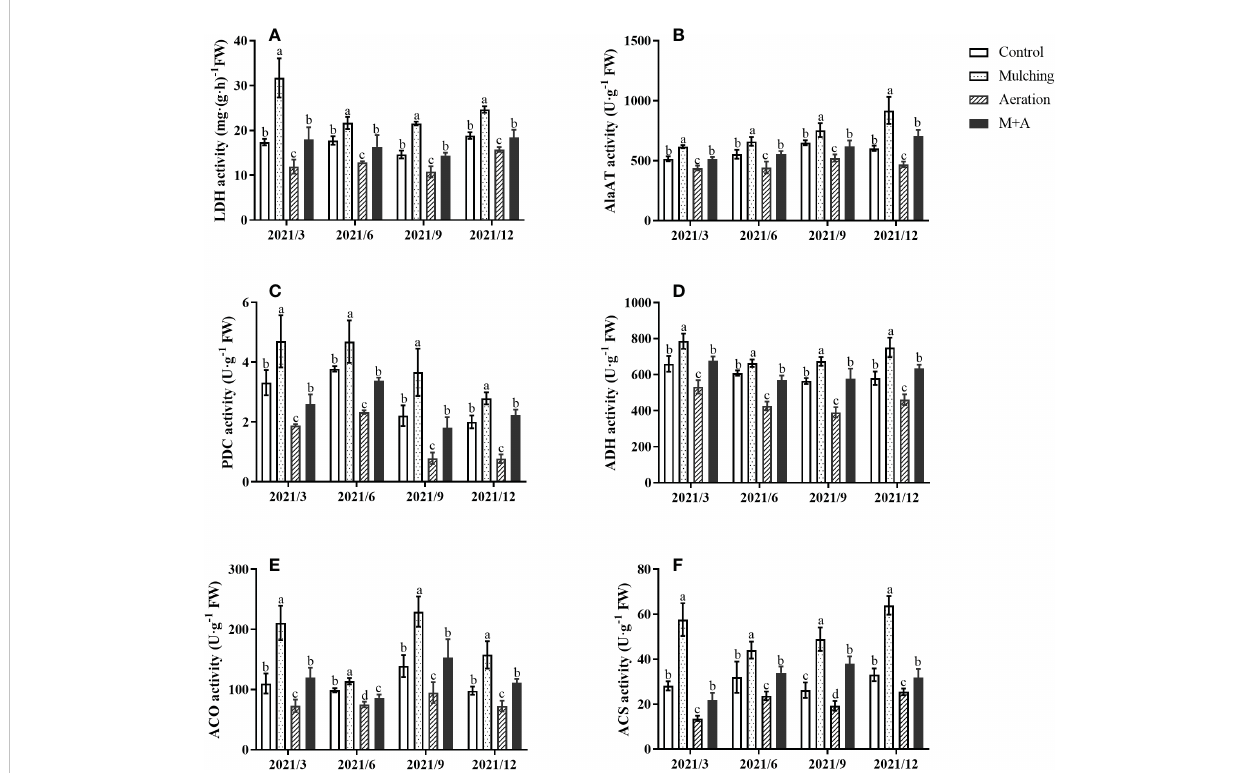
FIGURE 3 Effects of aeration on the activities of LDH (A) , AlaAT (B) , PDC (C) , ADH (D) ACO (E) and ACS (F) in the bamboo forest under mulching conditions (Control, Mulching, Aeration, M + A). The vertical bars ± re fl ect the standard deviation of the mean. Different letters in the same period represent different signi fi cance ( p< 0.05). LDH, lactate dehydrogenase; AlaAT, alanine transaminase; PDC, pyruvate decarboxylase; ADH, alcohol dehydrogenase; ACO (ACC oxidase) and ACS (ACC synthase).